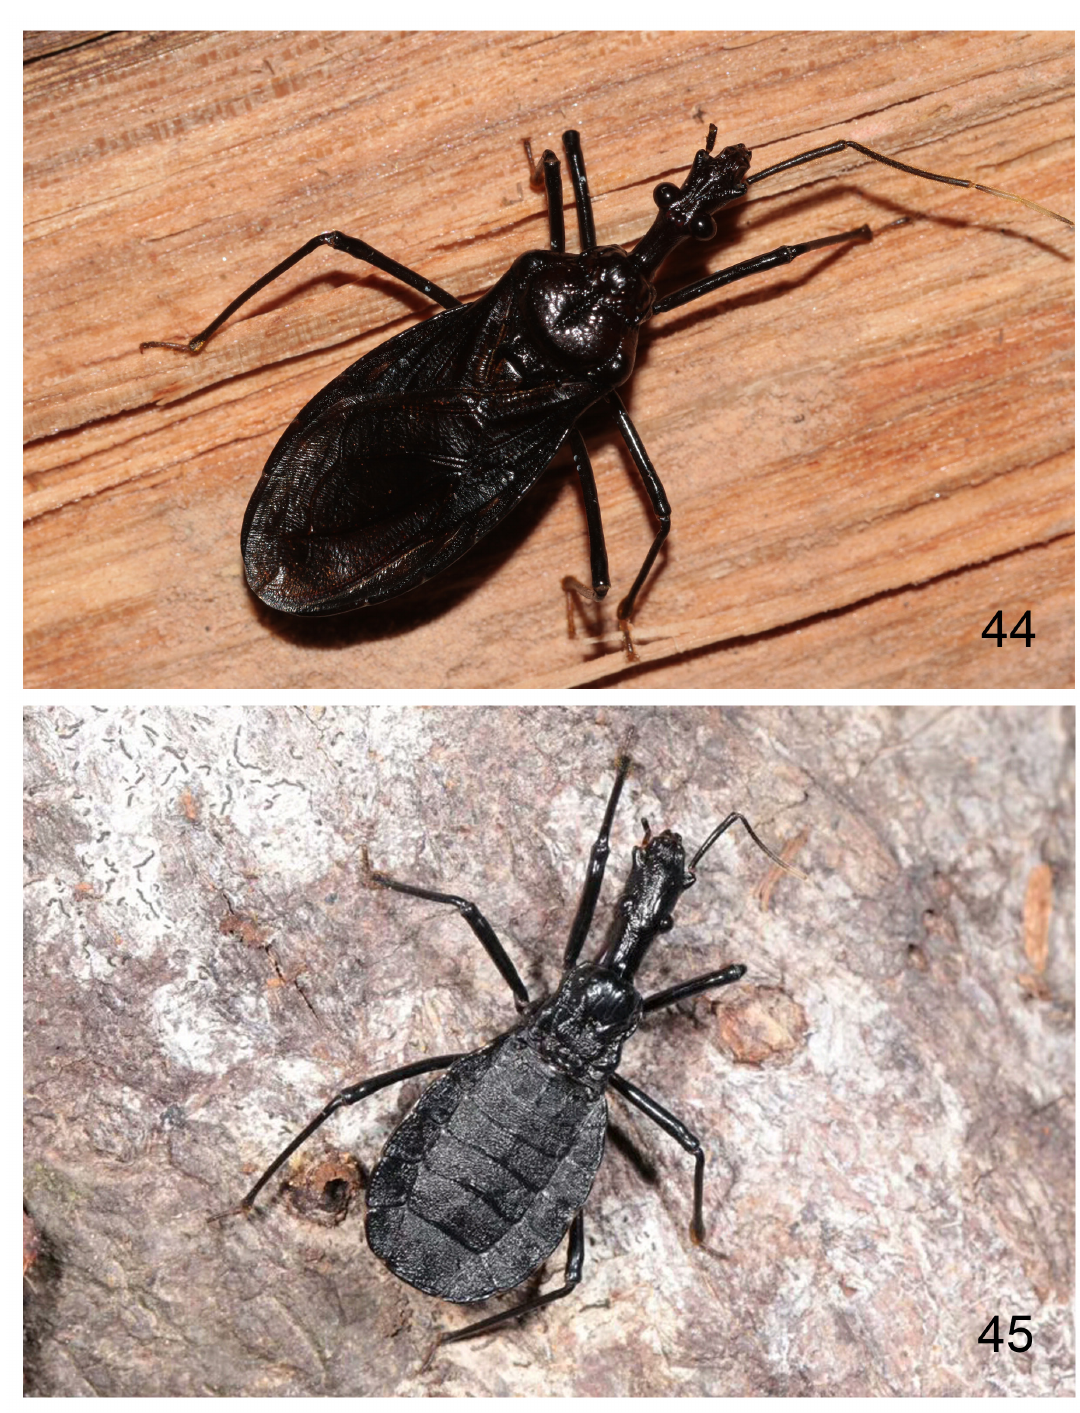
Figs 44–45. Xenorhyncocoris attractivus sp. nov. 44 . Living male. 45 . Living female. © Weiwei